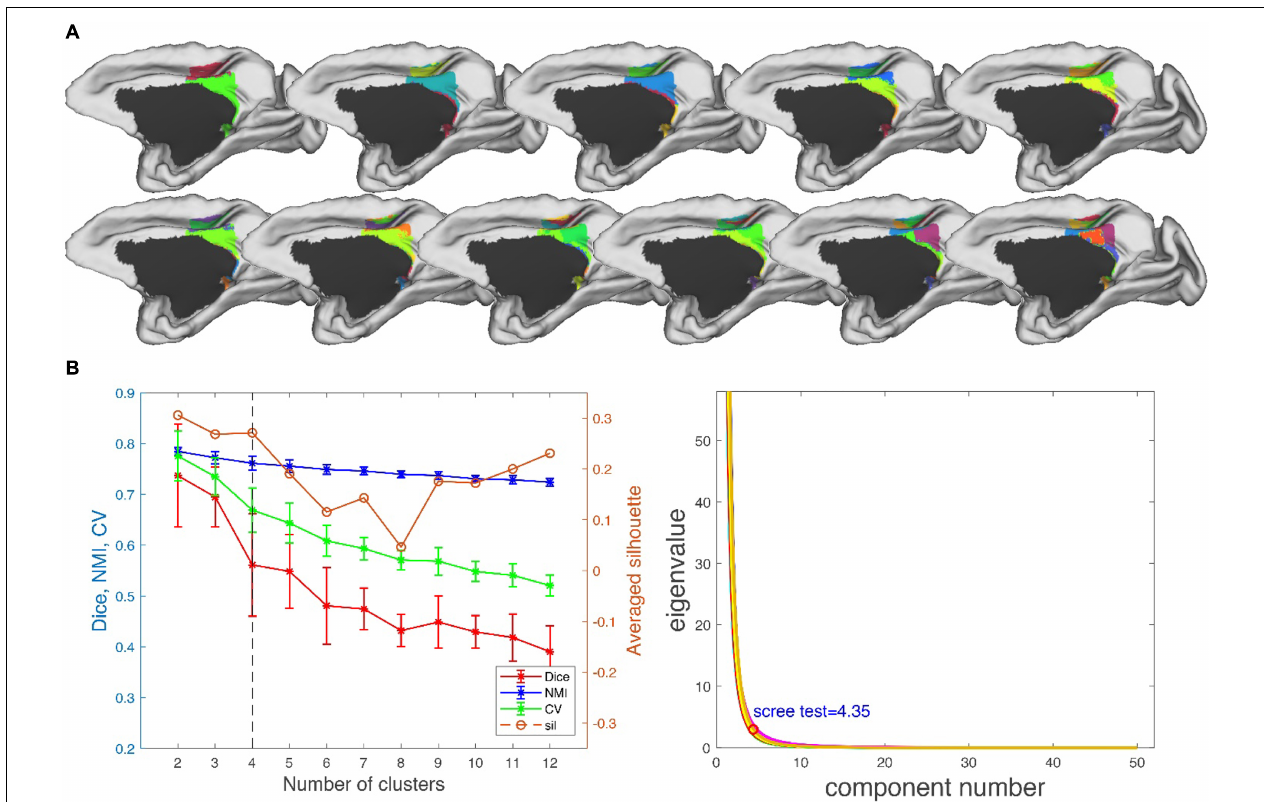
FIGURE 6 | Parcellation results of right posterior cingulate gyrus (PCG.R). (A) The maximum probability maps (MPMs) of PCG.R with 2–12 clusters. Note that there is no consistency among subareas with the same color in different results. (B) Validity indices of the parcellation results for PCG.R using leave-one-out resampling technique with 200 repetitions (left) and principal component analysis (PCA) (right). Thereinto, the relative higher value of Dice, NMI, CV, and sil hint the more consistent result across the whole parcellations. The error bars represent standard deviation. The optimal result of 4 clusters seems the most reasonable according to these indices, which is consistent with the result of